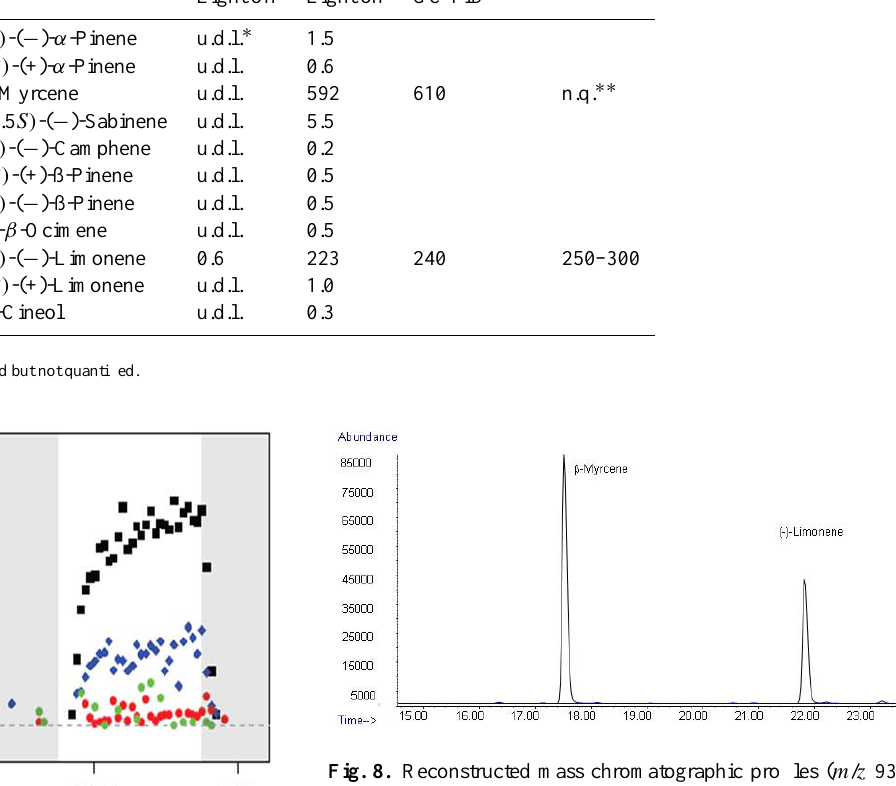
Fig. 8. Reconstructed mass chromatographic profiles ( m / z 93) of monoterpenes present in the emission of potted Q. ilex during light and dark ((overlaid in blue) conditions.